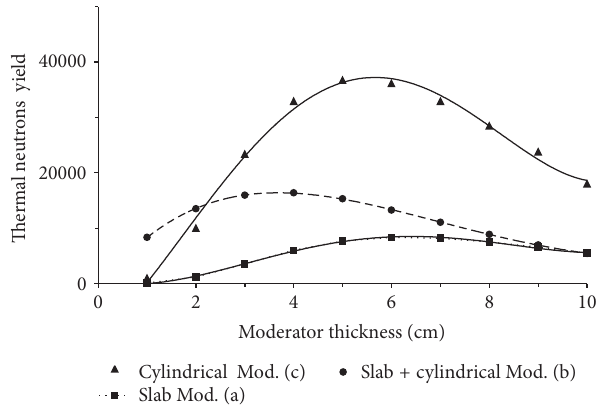
Figure 2: Thermal neutron yield at the sample location from the three geometries study—(a) slab moderator, (b) slab-cylindrical moderator, and (c) cylindrical moderator plotted as a function of the effective moderator